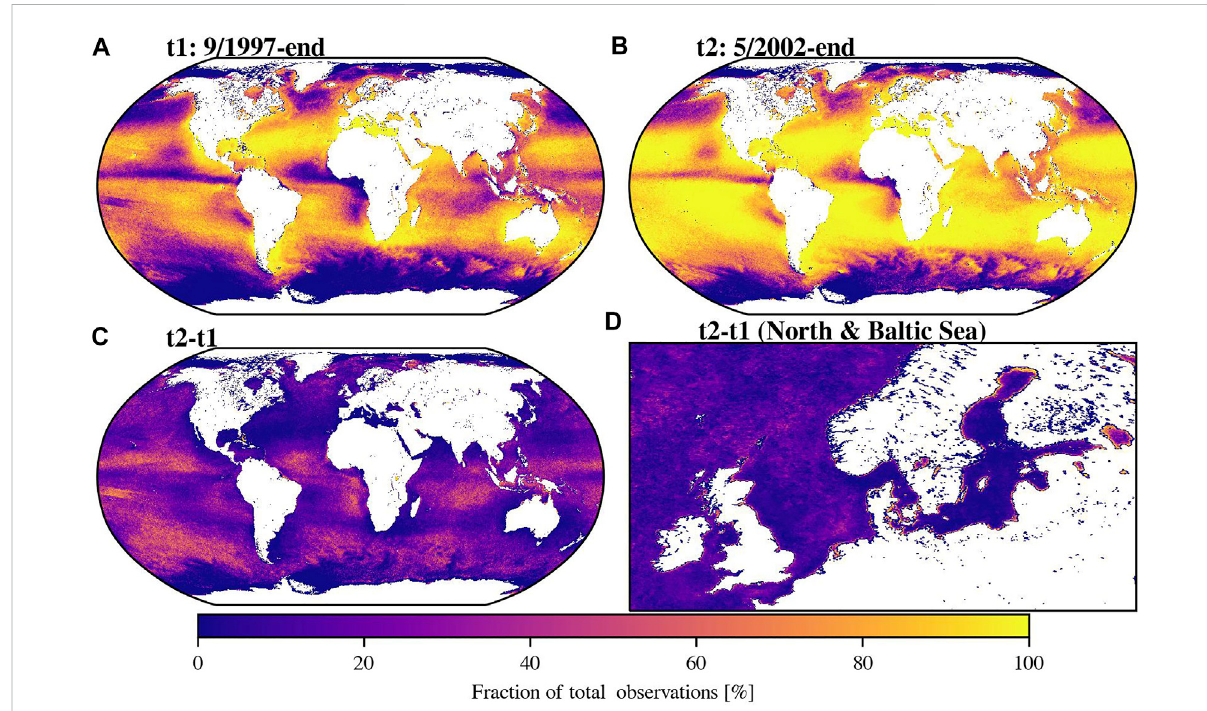
FIGURE 9 Datakeptafter applyingtheTGDM: (A) Thefractionofobservationsofthefullperiod, t1 ,and (B) theperiod t2 (5/2002 – 6/2020). In t2 theperiod when only SeaWiFS is active, is not included. Difference in data coverage between t1 and t2 , globally (C) and in detail, its subset (D) for the Baltic-, North Sea, and surrounding sea.